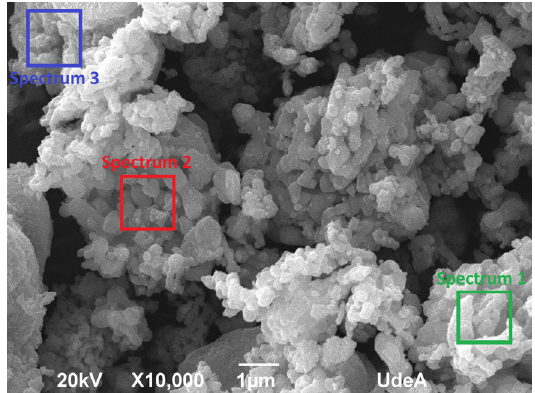
Figure 7. Selected zones in the SEM micrograph of the initial mixture of reactants for evaluation of elemental chemical composition.